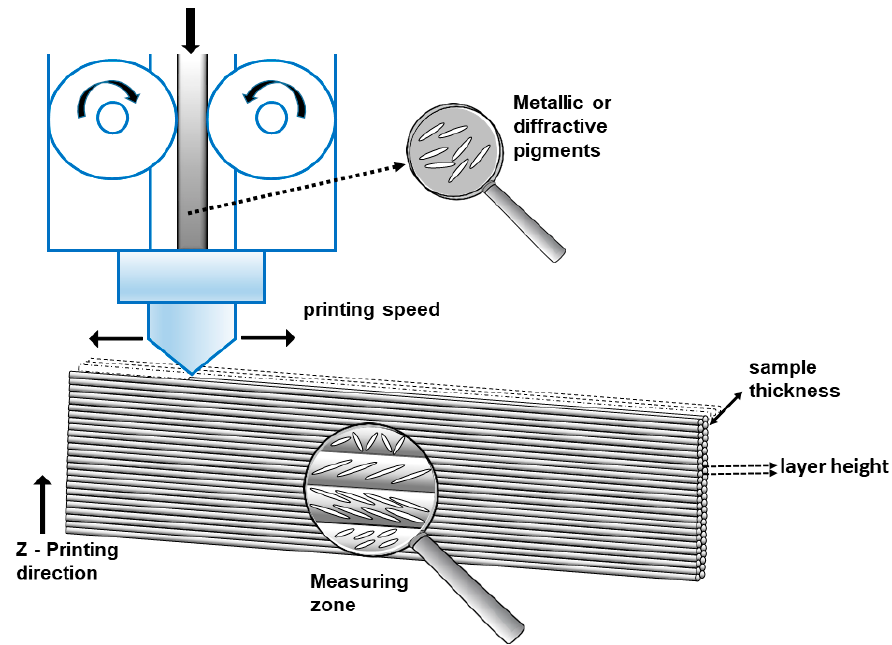
Figure 3. Printing factors schematic with the controlled and changed parameters and the possible disposition of the metallic/diffractive pigments across the printed sample.